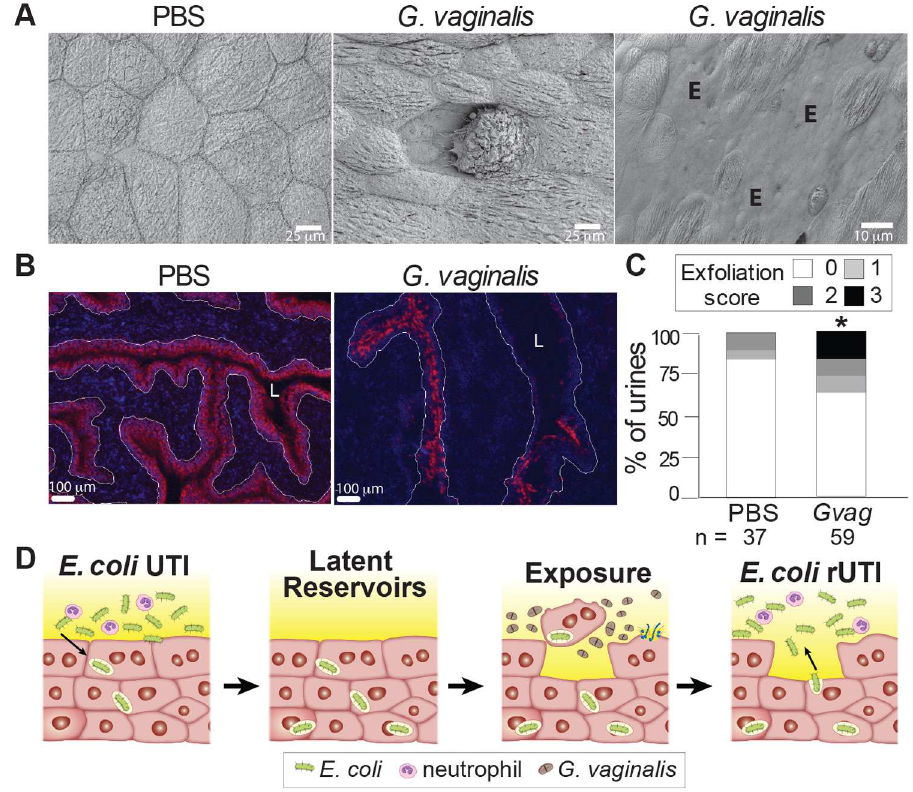
Fig 2. G . vaginalis causesurothelial exfoliation. ( A ) Scanning electron micrographs of splayedbladders showingthe superficial hexagonal urothelialcells that line the bladderlumen. N = 2 independent experiments. PBS, n = 3; G . vaginalis n = 7. ‘E’ denotesareas of exfoliation. ( B ) Immunofluorescence microscopy of bladdersections. Red—uroplakin IIIa (superficial epithelial cells); Blue—DAPI. White lines—epithelial basementmembrane; L—bladderlumen. N = 3 independent experiments; n = 2–5 mice per group. ( C ) Blindedscoringof urothelialcells in urine sedimentscollectedbetween3 and 24 h after two PBS or G . vaginalis exposures. N = 3 independent experiments; PBS, n = 37; G . vaginalis ,n = 59. * P = 0.0374 by Fisher’s exact test. ( D ) Schematic model of G . vaginalis -induced recurrent E . coli